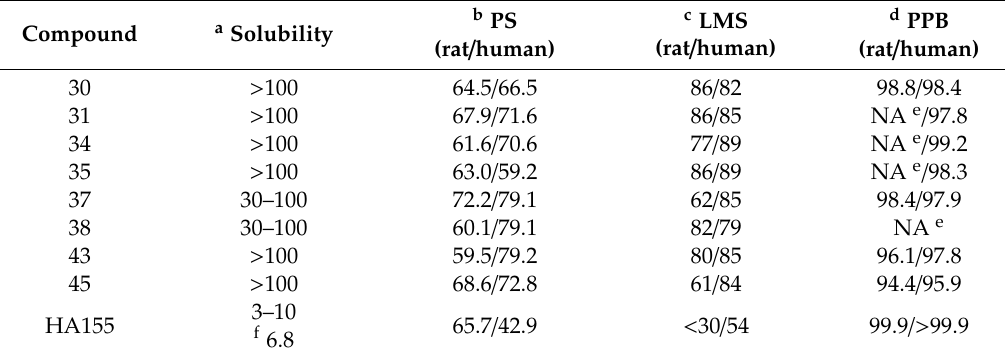
Table 2. In vitro ADME profile of selected